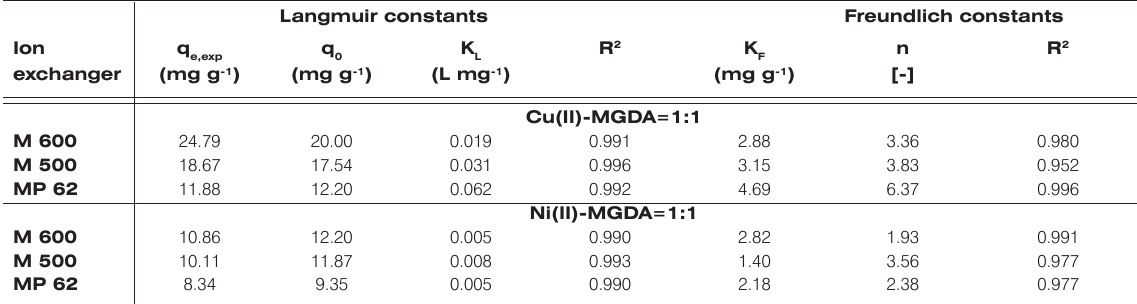
Table 6. Temkin and Dubinin-Radushkevich (D-R) isotherm parameter values for Cu(II) and Ni(II) ions in the presence of MGDA on Lewatit MonoPlus M 600, Lewatit MonoPlus M 500 and Lewatit MP 62. Temkin constants